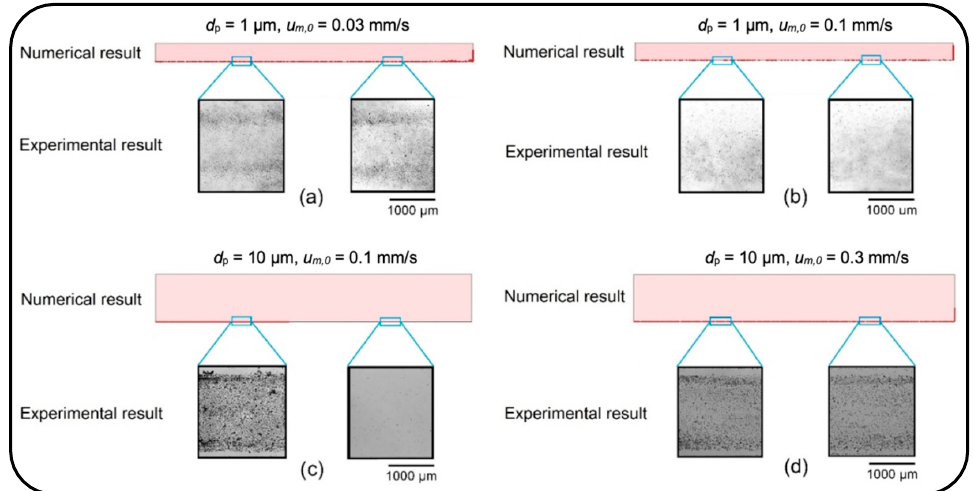
Figure 6. Qualitative comparison of distribution and deposition of the particles on the microchannel substrate obtained from numerical and experimental studies. ( a ) d p = 1 µ m, u m ,0 = 0.03 mm/s; ( b ) d p = 1 µ m, u m ,0 = 0.1 mm/s; ( c ) d p = 10 µ m, u m ,0 = 0.1 mm/s; and ( d ) d p = 10 µ m, u m ,0 = 0.3 mm/s.